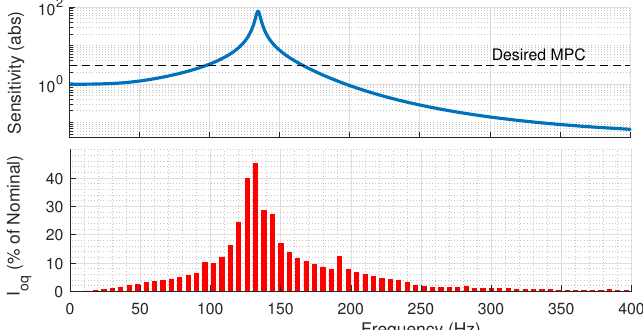
Figure 11. Predicted sensitivity function and produced distortions during grid transient.